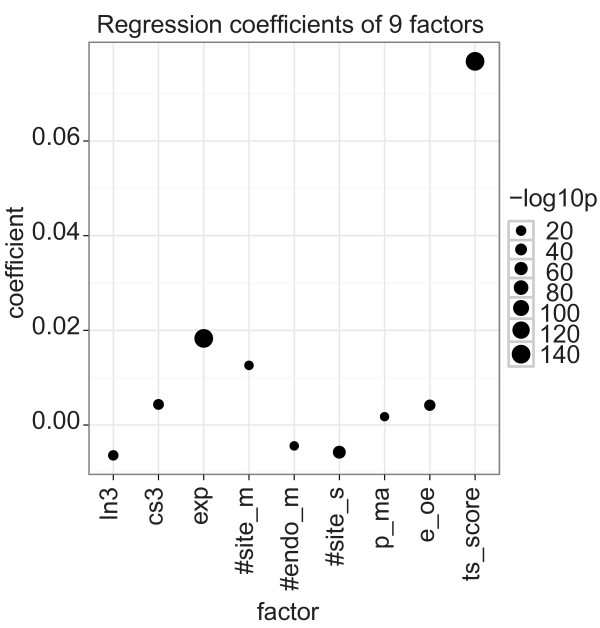
Coefficients of a linear regression with nine factors. The dot plot shows the coefficients of the liner model with formula: -log ratio = ln3 + cs3 + exp +#site_m + #endo_m + #site_s + p_ma + e_oe + ts_score. The dot size shows -log10 of the coefficient's p-value. Positive coefficients associate with miRNA down-regulation. miRNA, microRNA.